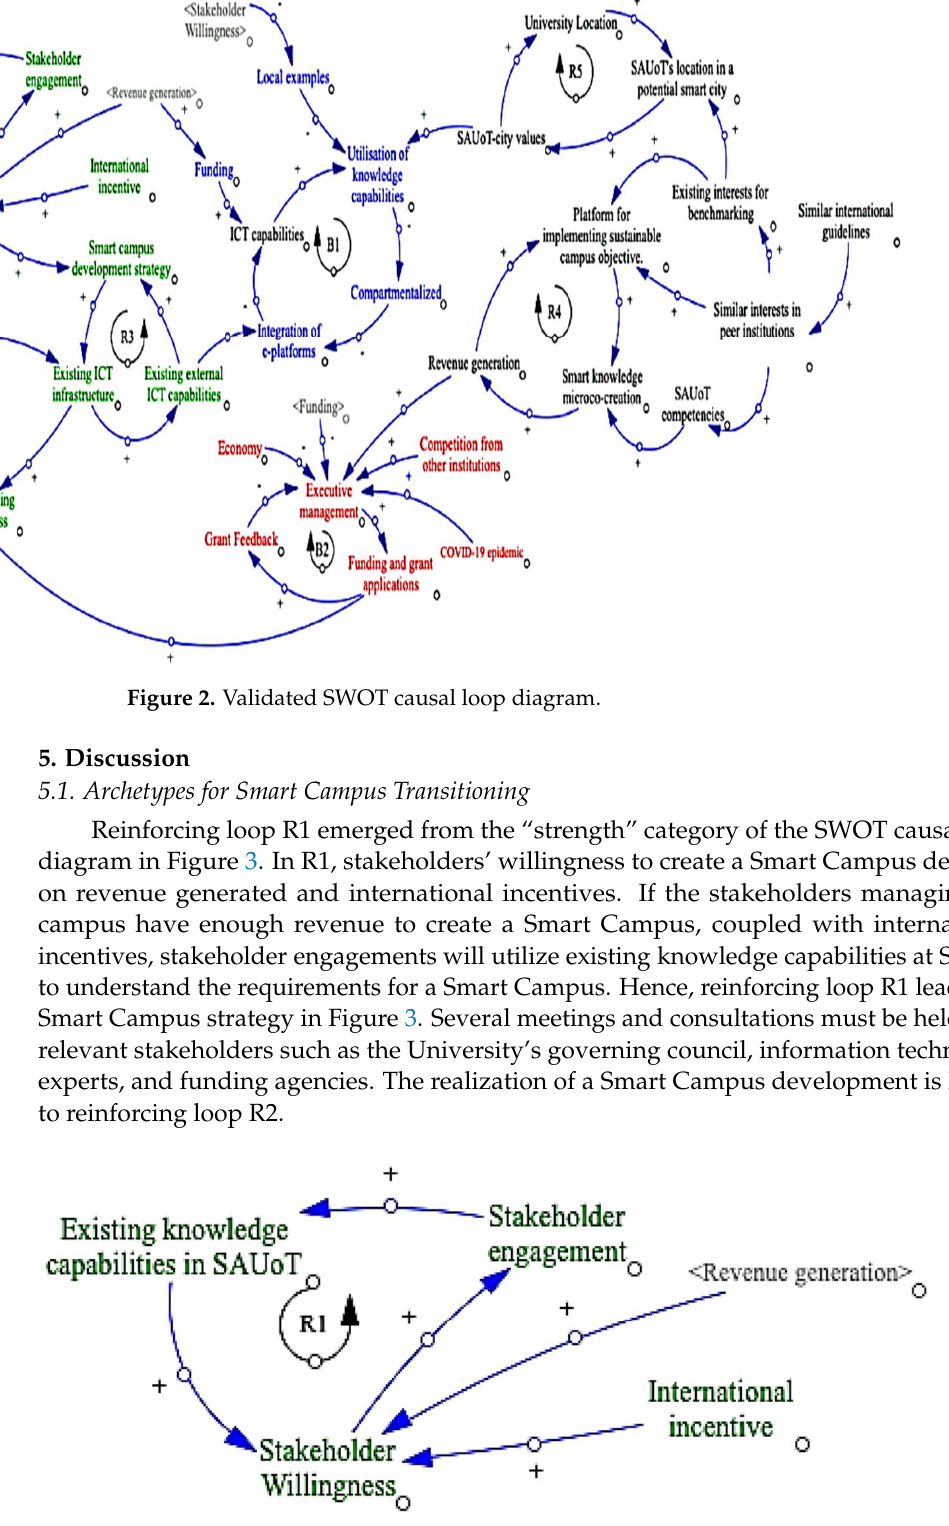
Figure 3. Reinforcing loop R1.